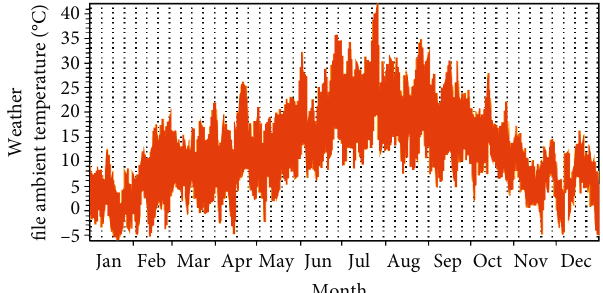
Figure 19: Time series data of ambient